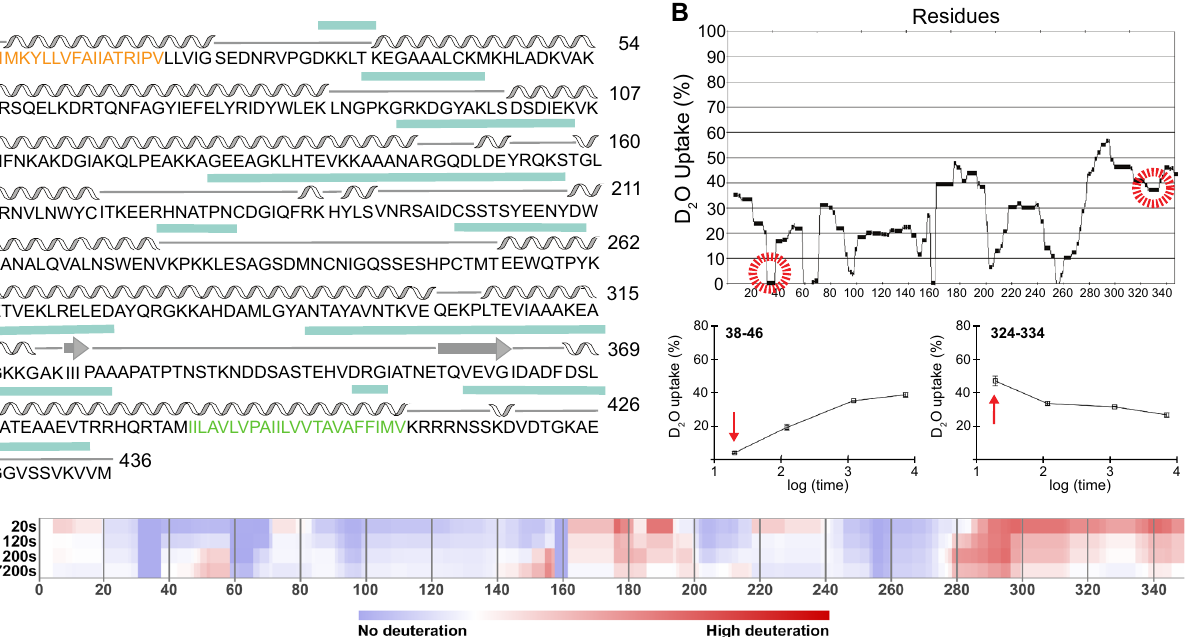
Figure 1. Mapping of ISG65 low-complexity regions. ( A ) Secondary structure prediction of ISG65 adapted from PSIPred 19,20 . Helices are depicted as wavy lines, beta strands as arrows and disordered sections as straight lines. Regions with a low confidence score are marked with a turquoise box above the sequence. Positions of signal-peptide and transmembrane domain are depicted in orange and green, respectively. ( B ) Uptake plot showing the incorporation of deuterium across the sequence of ISG65 20 s after start of the deuteration reaction (main panel). Selected peptides showing the rates of deuterium uptake over time representative for an ordered (bottom left) or disordered (bottom right) region. Red arrows mark the 20 s timepoint. The HDX-MS experiment was performed in triplicates. ( C ) Chiclet plot illustrating the relative deuteration across the sequence of ISG65 at 20, 120, 1200 and 7200 s of deuteration, adapted from MSTools 28 . The amount of relative deuteration is gradually colour coded from blue (no deuteration) to red (high